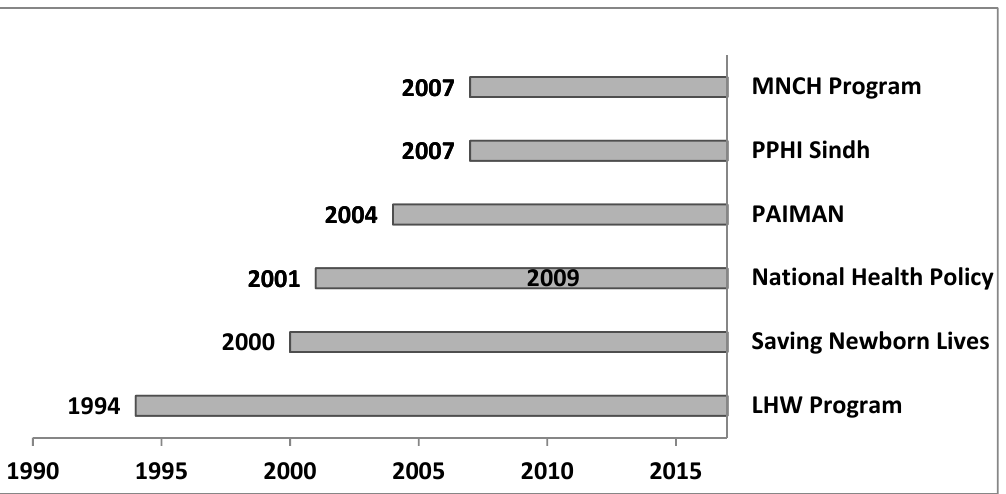
Figure 7. Timeline showing the starting year of health policies and programs with maternal, newborn, and child health (MNCH) components in Pakistan.